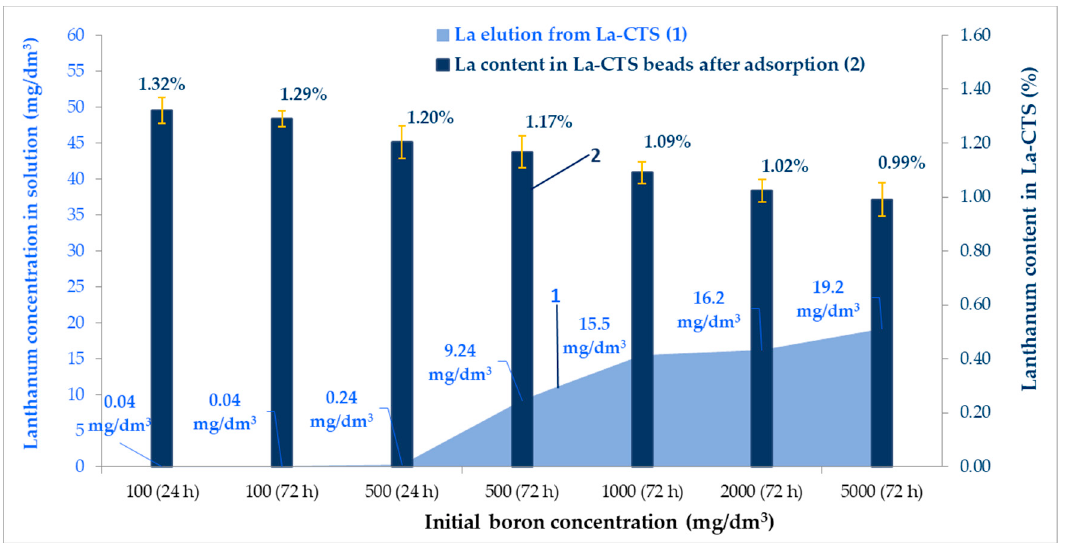
Figure 10. The influence of the initial boron concentration and time on the elution of lanthanum ions from the La-CTS hydrogel beads (graph 1) and on the content of lanthanum in the La-CTS bio-adsorbent (graph 2) during adsorption.